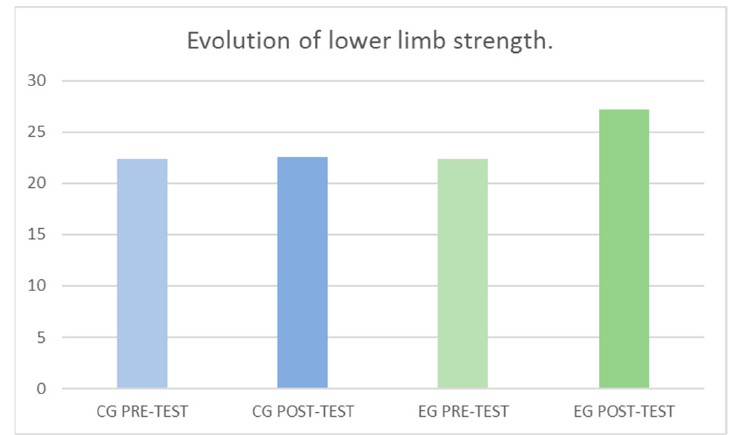
Figure 3. Evolution of lower limb strength between groups and pre-post-test.